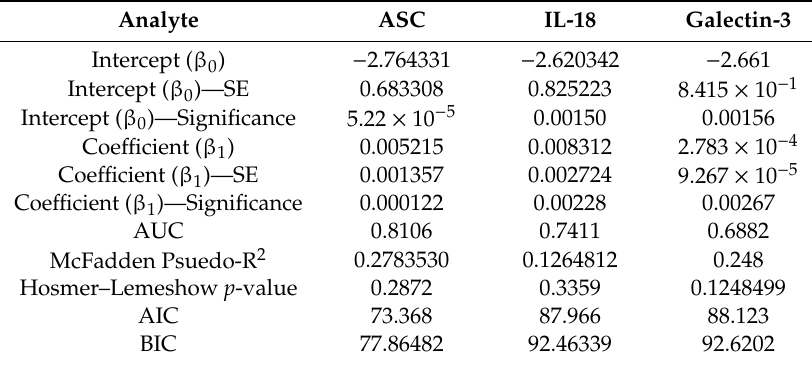
Table 3. Univariate analysis.